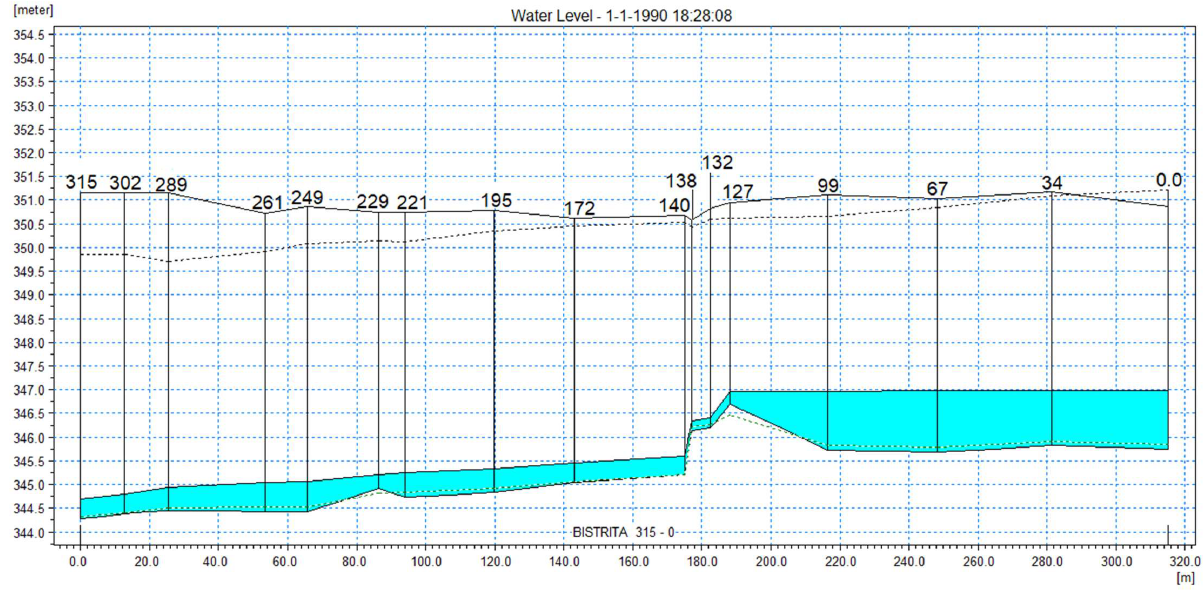
Figure 6. Water level for flow Q = 3.56 m 3 /s, summer flow recorded in June 2022. For the case where there is only one weir, the existing one.